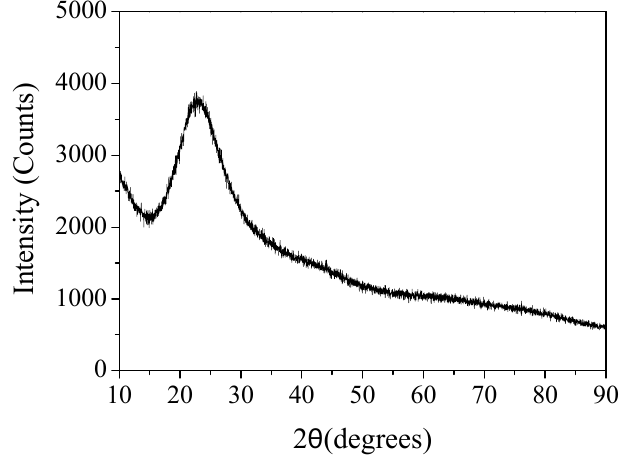
Figure 2. Wide ‐ angle XRD pattern of Pd/Fe nanoparticles supported on mesoporous silica. Weight percentage of iron to silica is 2.50%, and weight percentage of Pd to Fe is 0.075%.